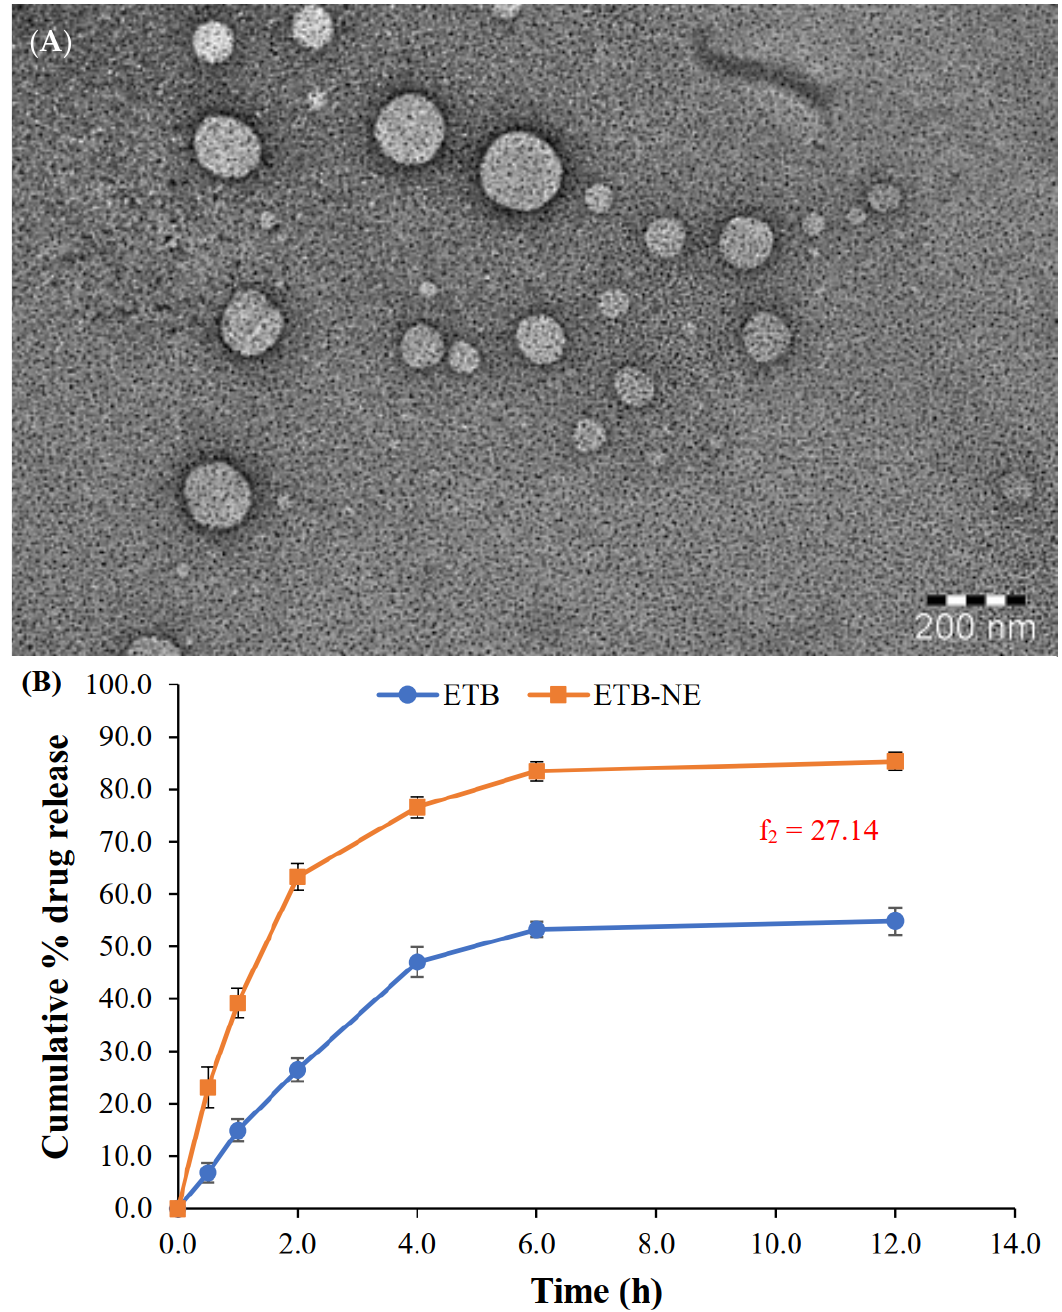
Figure 4. ( A ) TEM image of ETB-NE. ( B ) In vitro drug release profiles from the aqueous dispersion of ETB and ETB-NE (f 2 = 27.14).